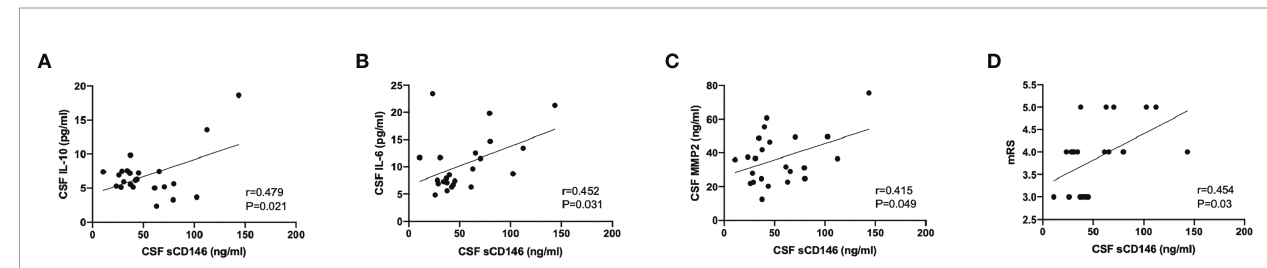
FIGURE 2 | CSF sCD146 was positively correlated with neuroin fl ammatory factors in the CSF and with mRS score (A – D) .